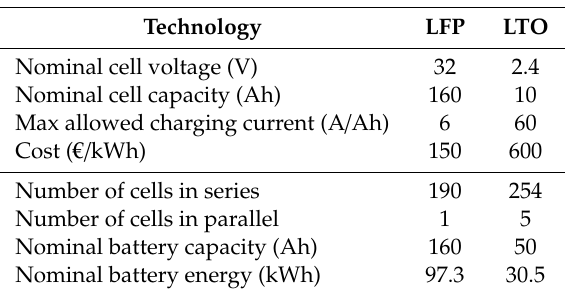
Figure 4. Scheme of the ESS equipped with storage system. Table 6. Storage system